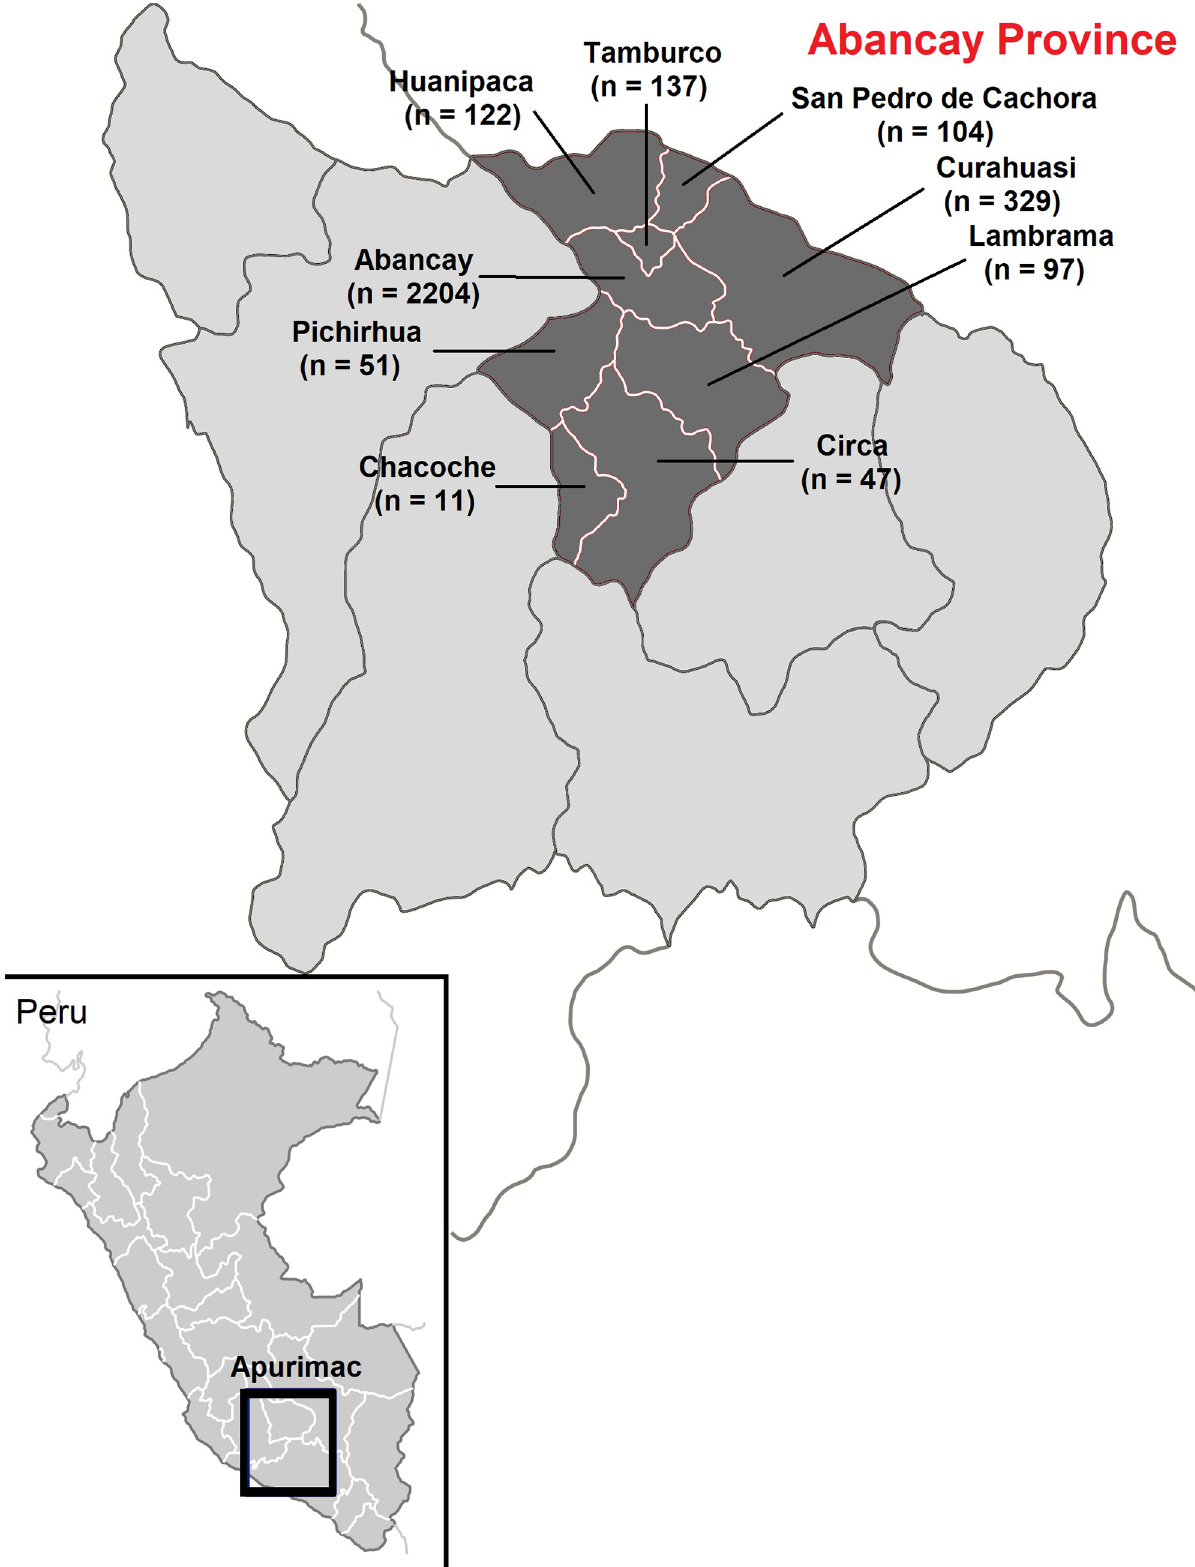
Fig 1. Geographic location of Abancay province in Peru.